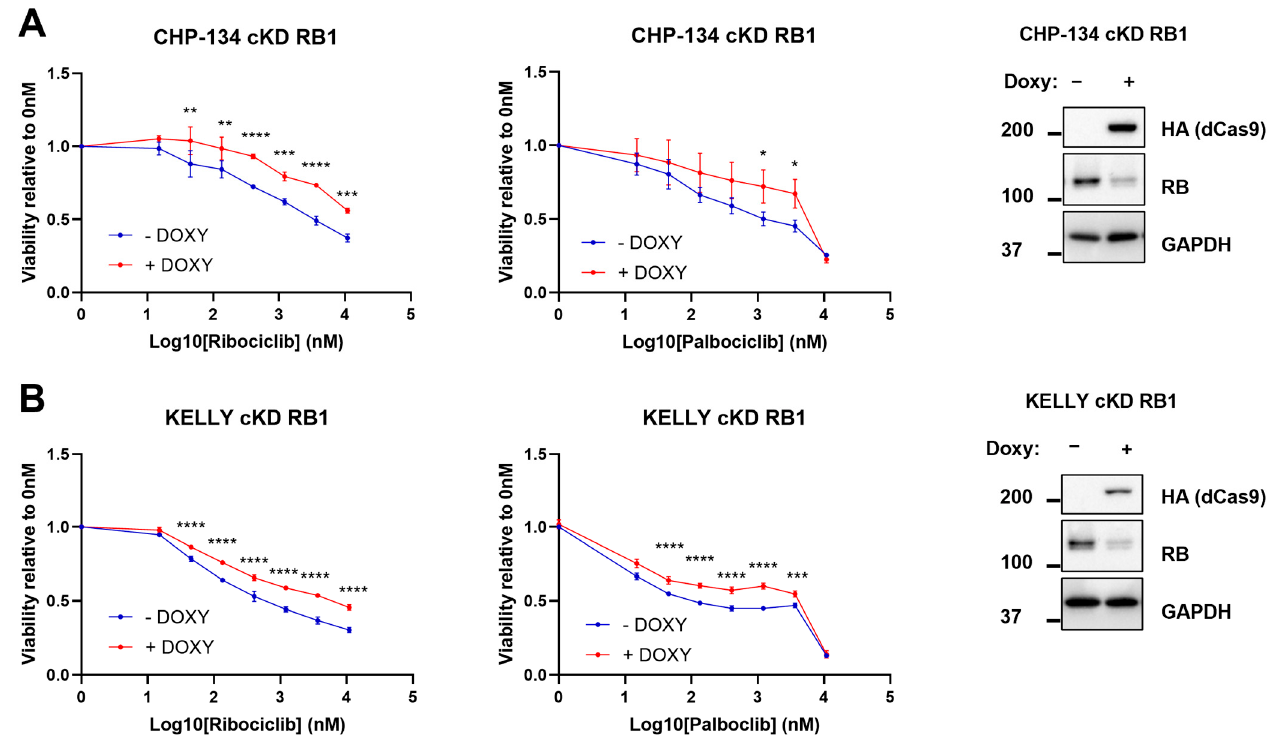
Figure 5. RB1 downregulation induces resistance to CDK4/6 inhibitors ribociclib and palbociclib. CHP-124 and kelly cKD RB1 cells were seeded at low confluence and treated with ribociclib or palbociclib for 72 h in the presence or absence of doxycycline. ( A ) Left: MTS results of CHP-134 cKD RB1. Right: western blot confirming the correct downregulation of RB1. ( B ) Left: MTS results of kelly cKD RB1. Right: western blot confirming the correct downregulation of RB1. Data are plotted as absorbances normalized on the 0nM sample as averages of three (N = 3) independent experiments. Error bars represented SD. Statistical analysis was performed by two-way ANOVA comparisons between − doxy and + doxy samples per each concentration. *, **, ***, **** indicated p < 0.05, 0.01, 0.001, and 0.0001,